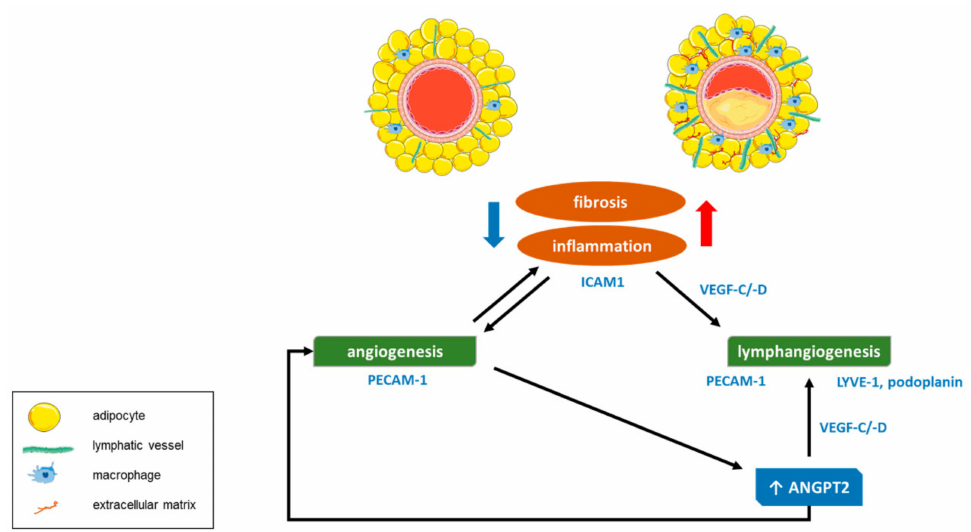
Figure 7. Schematic drawing depicting the main findings of this